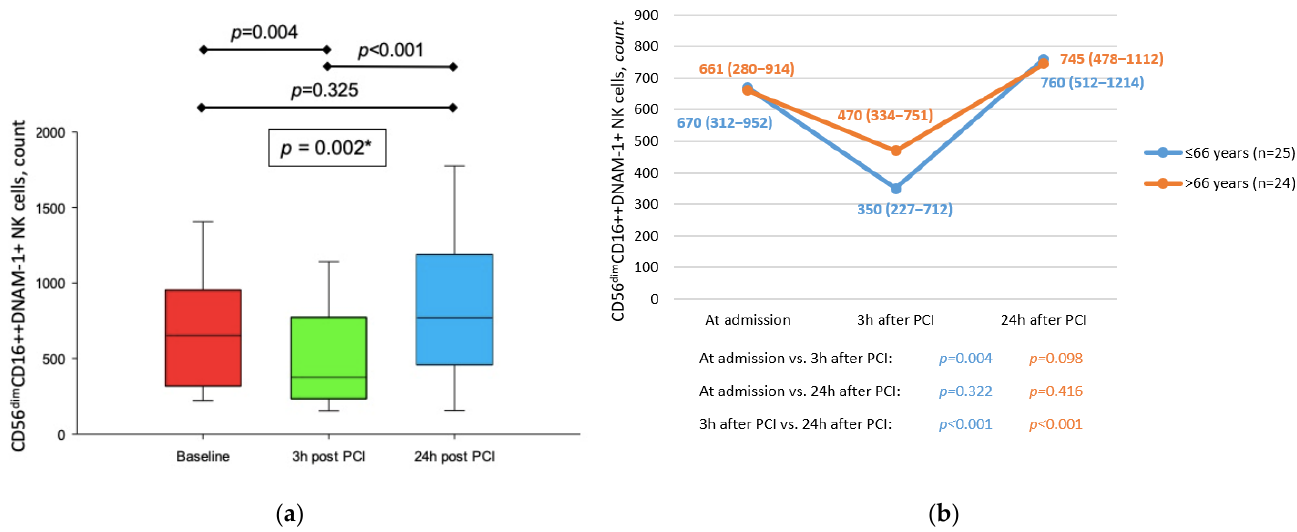
Total number of CD56dimCD16++DNAM-1+ NK cells in peripheral blood sample 3